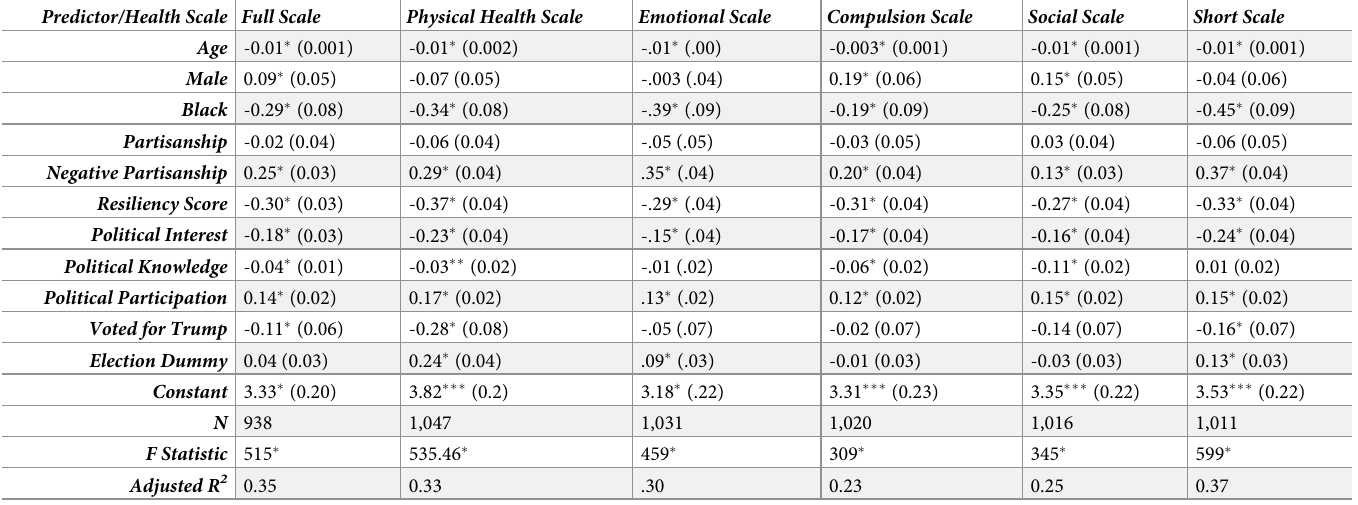
Table 2. Panel analysis of pre/post 2020 election political health scales. Predictor/Health Scale Full